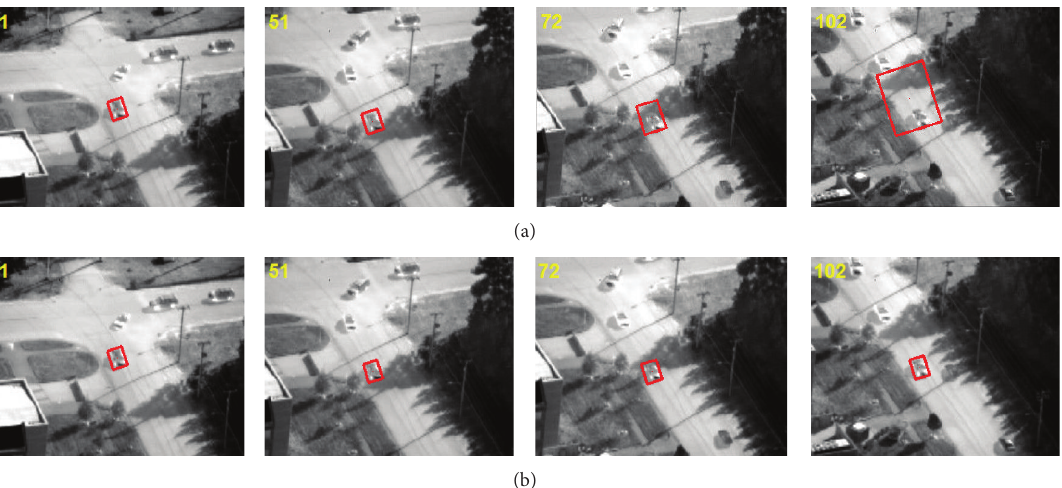
Figure 10: Tracking results for seq.4. The first row: results for IVT. The second row: results for our